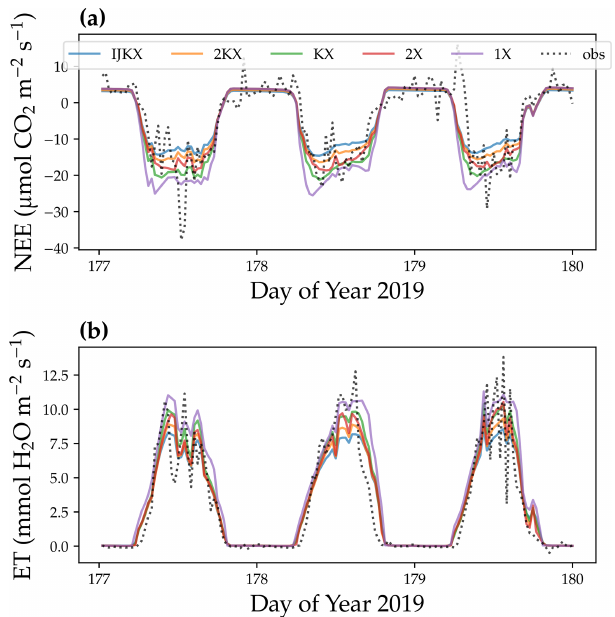
ent canopy complexity levels. (a) Site-level net ecosystem exchange of CO 2 (NEE). (b) Site-level evaporation transpiration using plant transpiration as a proxy (ET). The dotted lines were observations from a flux tower at Ozark, Missouri, USA (US-MOz). The colored lines were model simulations with a profile of vertical leaf pho- tosynthetic capacity using observed weather drivers from day 177 to 179 in the year 2019, such as air and soil humidity. For NEE, a more negative value means higher carbon flux; for ET, a higher value means higher water